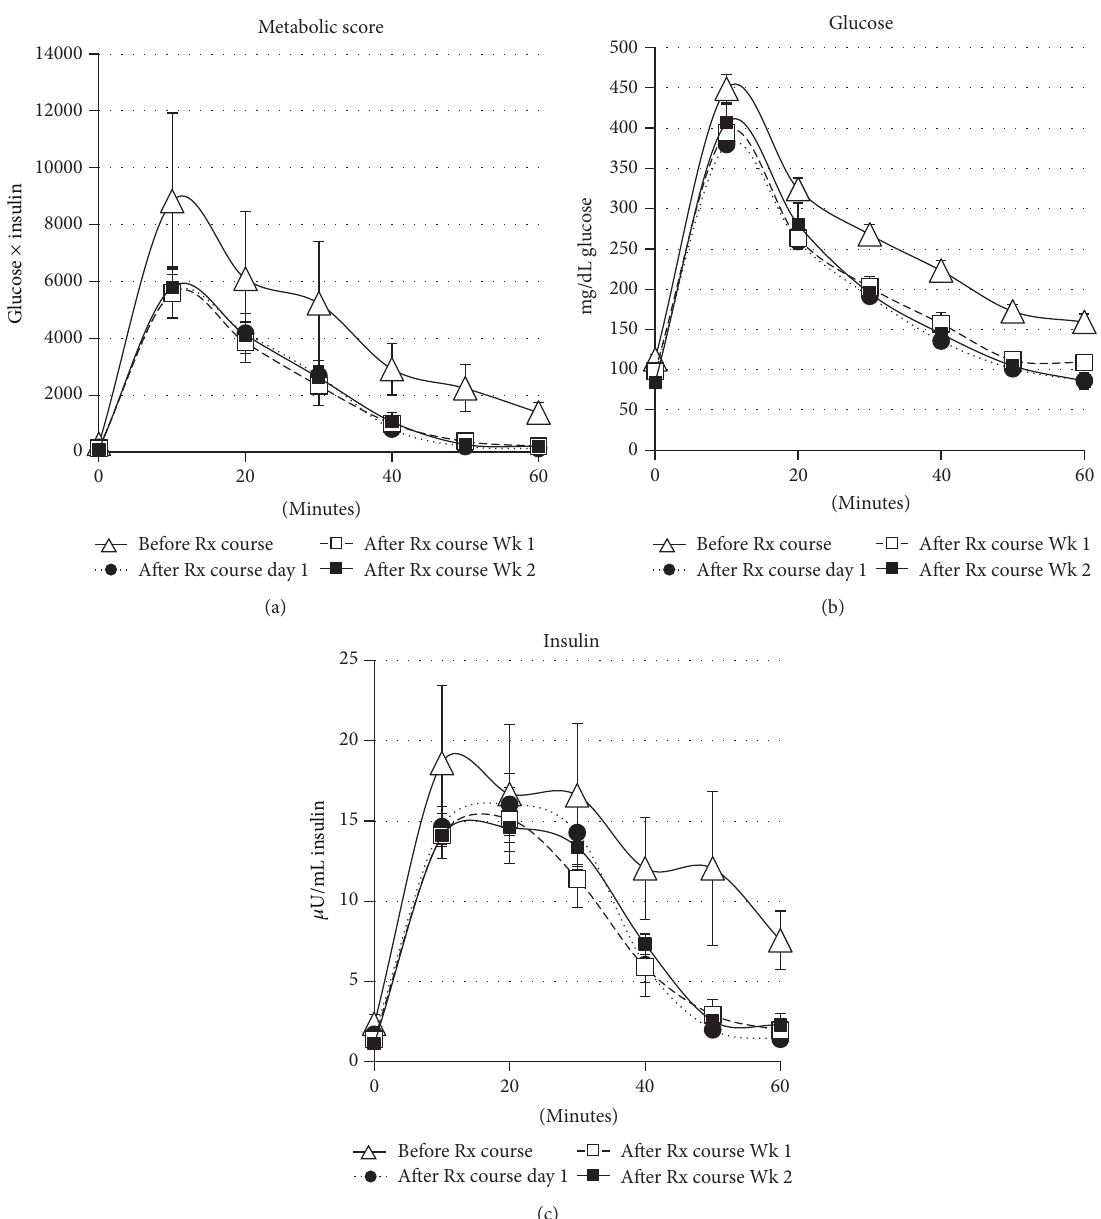
Figure 3: Ossabaw pigs (MET03 and MET04) were started on a high caloric, atherogenic diet at 2 months of age to incite development of metabolic syndrome, including insulin resistance. GTT was performed pre Rx course ( 󳵻 ), day 1 after Rx course ( e ), week 1 after Rx course ( ◻ ), and week 2 post Rx course ( ◼ ). A metabolic score (a), calculated by insulin × glucose levels obtained during GTT, indicated improved insulin sensitivity was conferred by SCD therapy. The effect persisted for 2 weeks after the SCD Rx course. The glucose levels (b) and insulin levels (c) used to generate the metabolic score are also shown. Average of 3 SCD Rx courses that consisted of three 6-hour SCD treatments in one week is shown ± SE ( 𝑛 = 3